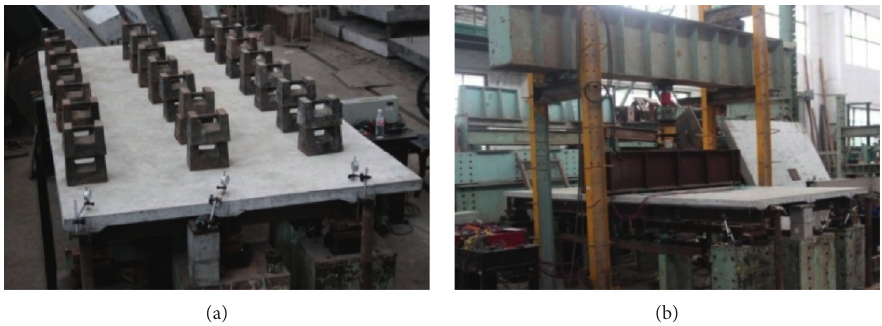
Figure 5: Pictures of the static tests: (a) weight loading test; (b) hydraulic loading